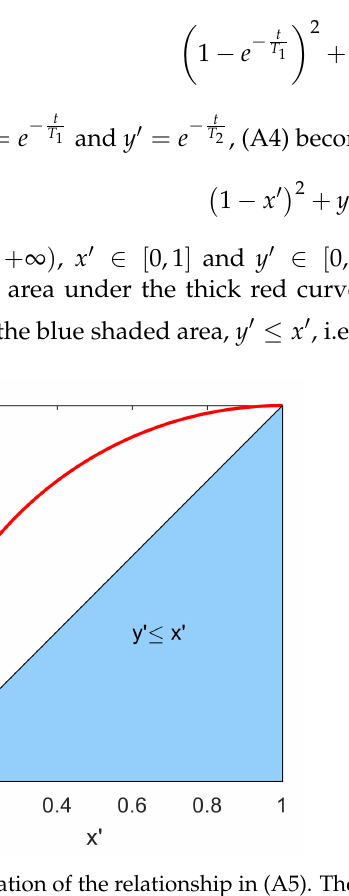
Figure A1. Illustration of the relationship in (A5). The area under the red curve represents all the x (cid:48) and y (cid:48) values that satisfy (A5). The blue shaded area corresponds with y (cid:48) ≤ x (cid:48) , implying T 1 ≥ T 2